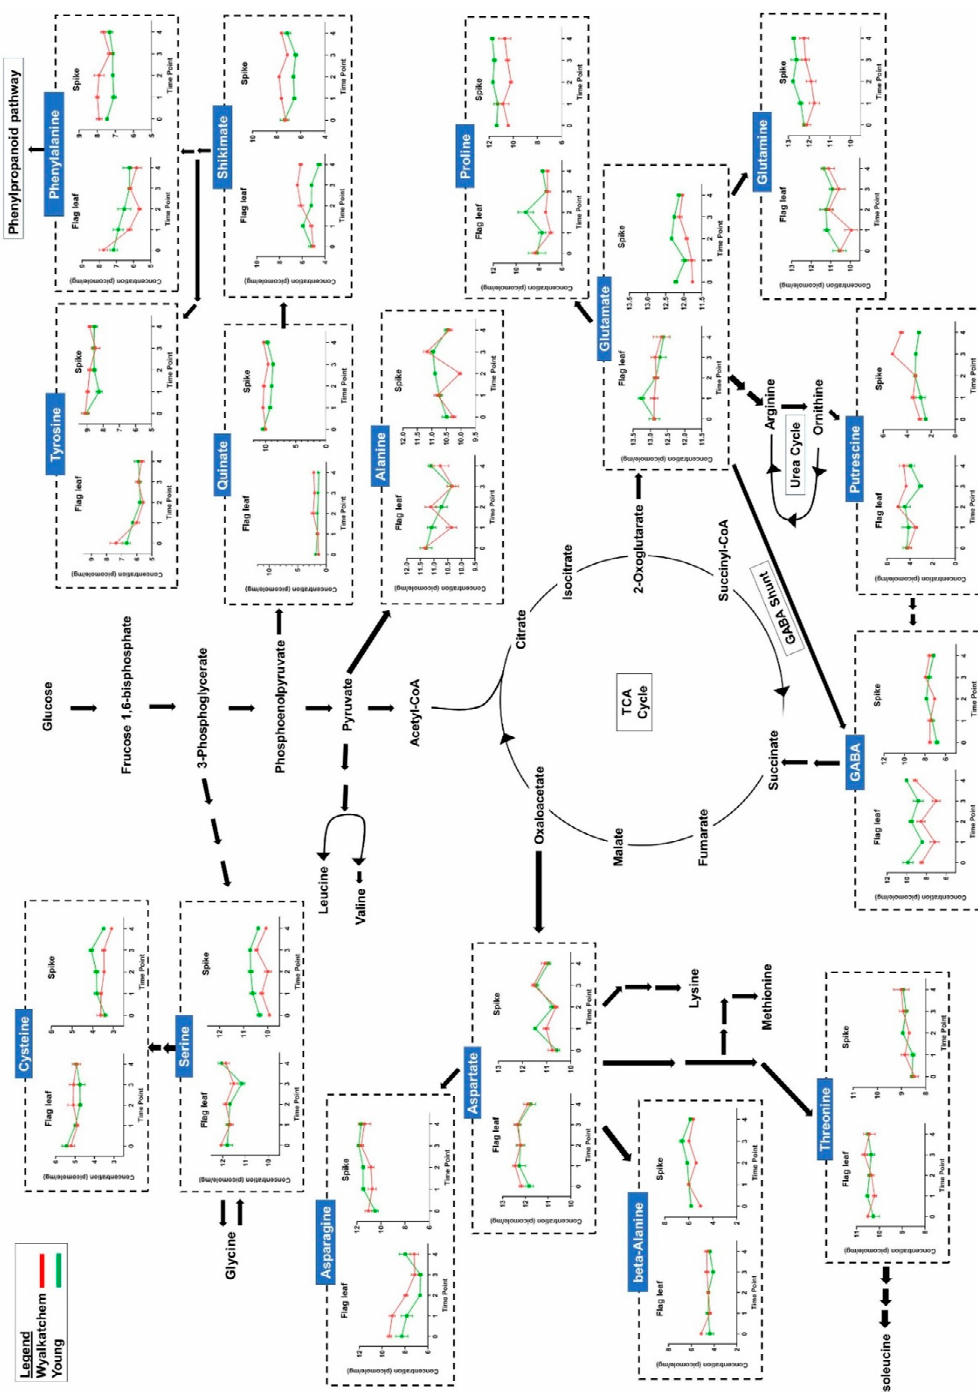
Figure 7. Comparison of amino acid and amine levels (picomole / mg of fresh weight and Log 2 - transformed), as well as their relationship to the main energy providing pathways (glycolysis and TCA cycle). The graphs show di ff erences in metabolite levels between flag leaf and spike metabolite data, as well as di ff erences in accumulation levels of those metabolites in cold-tolerant Young and cold-sensitive Wyalkatchem spikes. n = 4 ± SEM for flag leaf, n = 3 ± SEM for spike.